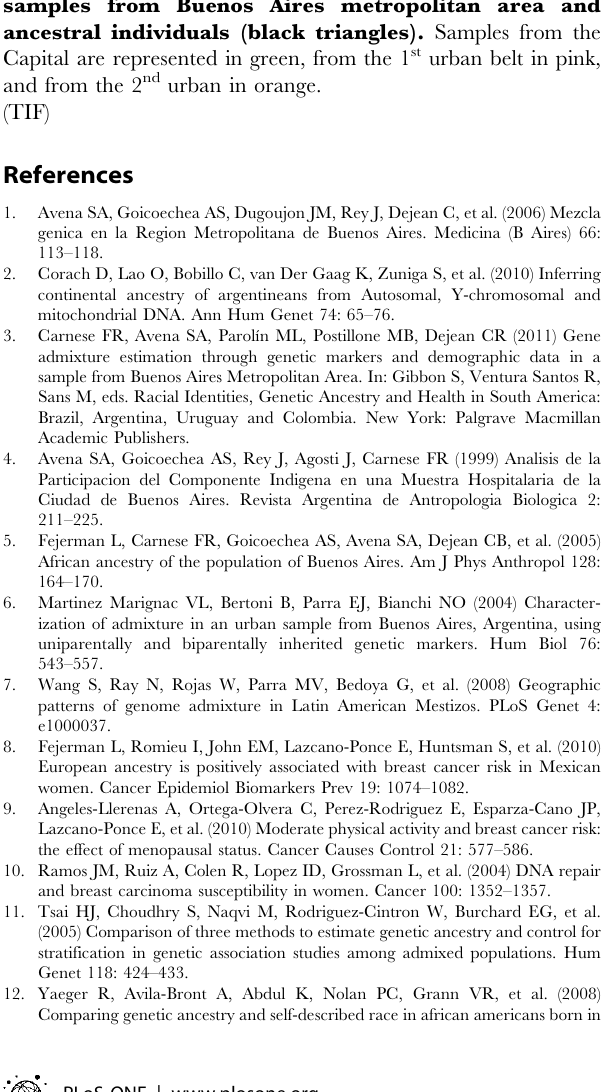
Figure S3 1 st and 2 nd Multidimensional components of samples from the cities of Buenos Aires, Mexico and San Juan, including European, African and Indigenous American ancestrals (black triangles). Samples from Buenos Aires are in gold, samples from Mexico are in light blue and samples from Puerto Rico are in purple. (TIF) Table S1 Individual information on the number of grandparents born in Argentina (by region), other South American country or Europe. (XLS) Table S2 List of ancestry informative markers (AIMs) with chromosomal position and allele frequency in European, African and Indigenous American samples. (XLSX) Table S3 Correlation coefficients between genome wide ancestry estimates and 99 ancestry informative markers (AIMs)